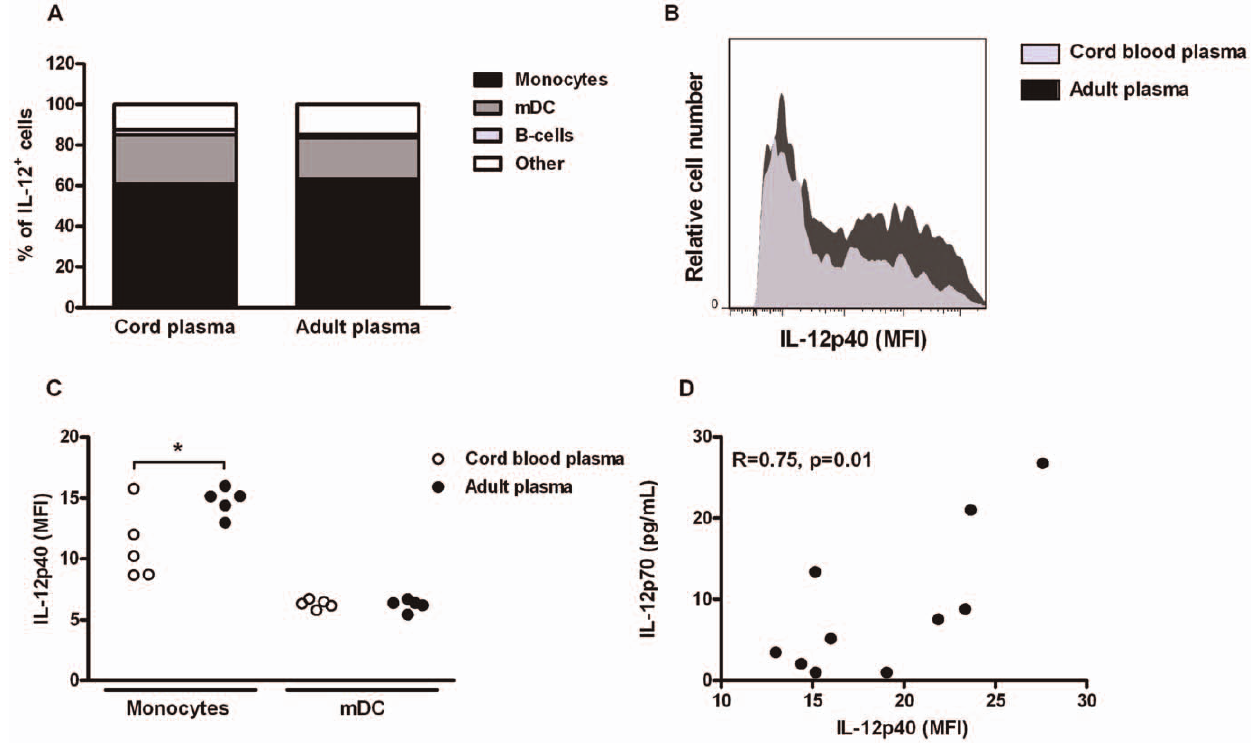
Figure 3. Cord blood plasma suppresses TLR4-mediated IL-12p40 production by primary monocytes. Adult PBMC were stimulated with LPS (100 ng/mL) and IFN- c (20 ng/mL) in the presence of 10% cord blood plasma or adult plasma. After 24 hours, intracellular levels of IL-12p40 in monocytes (CD14 + /HLA-DR + ), myeloid dendritic cells (mDC, CD3 2 /CD16 2 /CD56 2 /CD14 2 /HLA-DR + /CD11c + ) and B-cells (CD3 2 /CD16 2 /CD56 2 / CD19 + ) were determined by flow cytometry. A; Proportion of monocytes, mDC and B-cells among the total population of IL-12p40 + cells. Bars represent means of five different plasma samples. B; Representative histograms of monocyte IL-12p40 production upon TLR4-stimulation in the presence of cord blood plasma or adult plasma. C; Mean fluorescence intensity (MFI) of IL-12p40 in monocytes and mDC upon TLR4-stimulation in the presence of cord blood plasma or adult plasma. Each dot represents one individual plasma sample. D; Correlation between TLR4-mediated monocyte IL-12p40 MFI and IL-12p70 protein production by PBMC. Each dot represents one individual plasma sample. All data are representative of three independent experiments. *; p , 0.05.